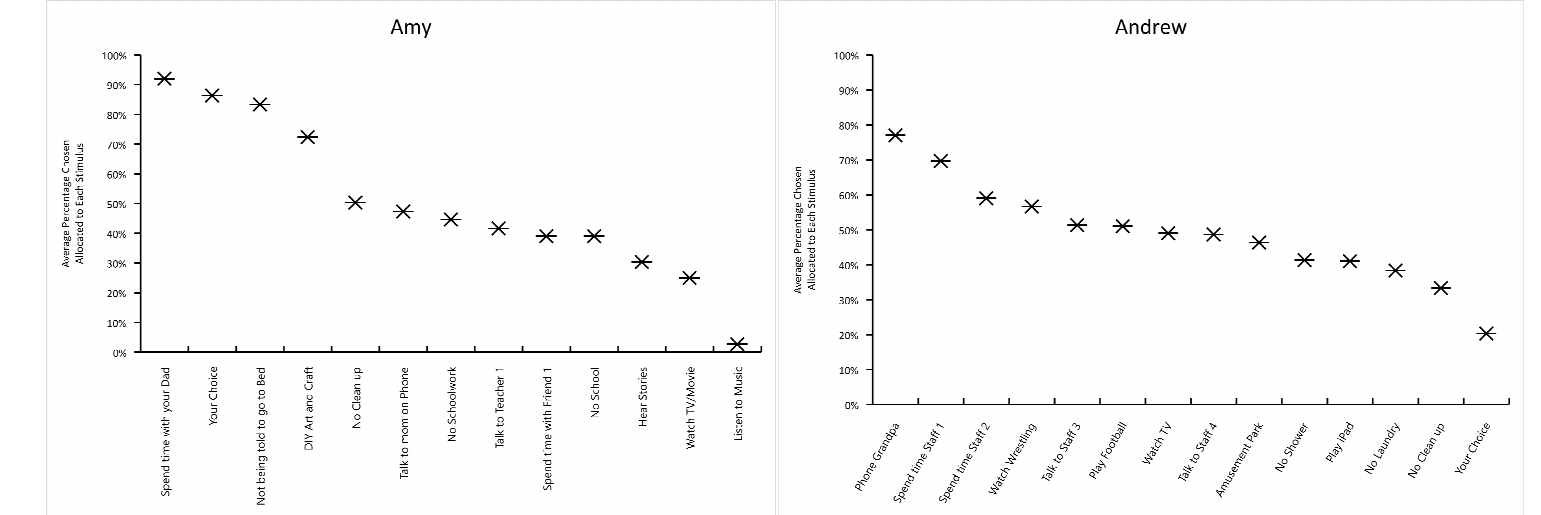
Figure 2. The average percentage chosen of the three sessions of the pictorial concurrent operant preference assessment for each participant.